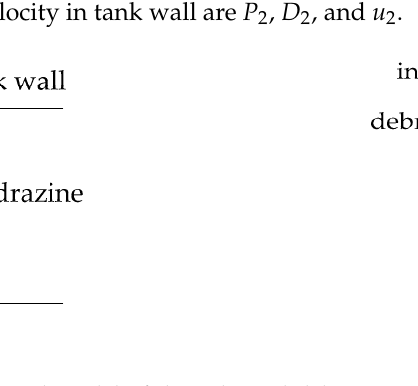
Figure 2. ( a ) One-dimensional model of the spherical debris impacting the outside of tank wall; ( b ) One-dimensional model of the spherical debris impacting the inside of tank wall.